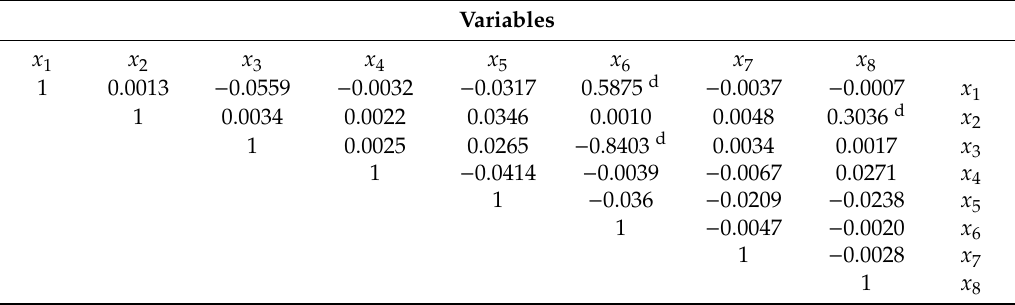
Table 2. Pearson’s correlation between independent variables of the models ( n = 856).